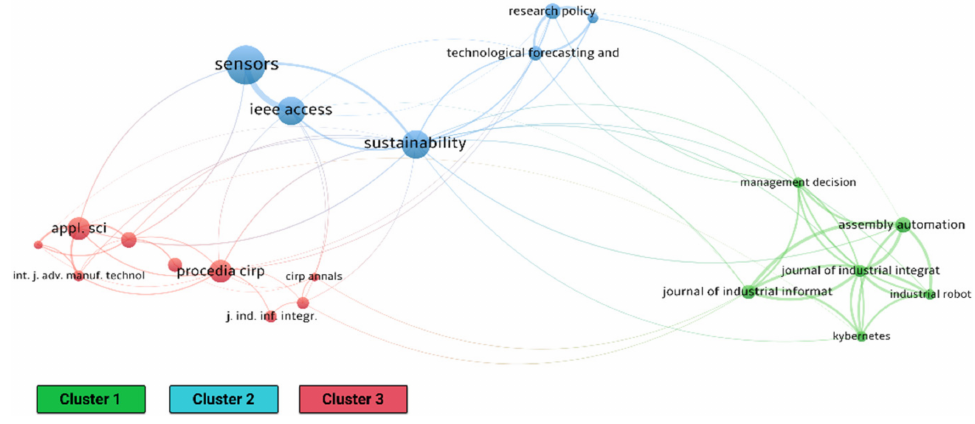
Figure 5. Co-citation analysis network of smart logistics in Industry 5.0.